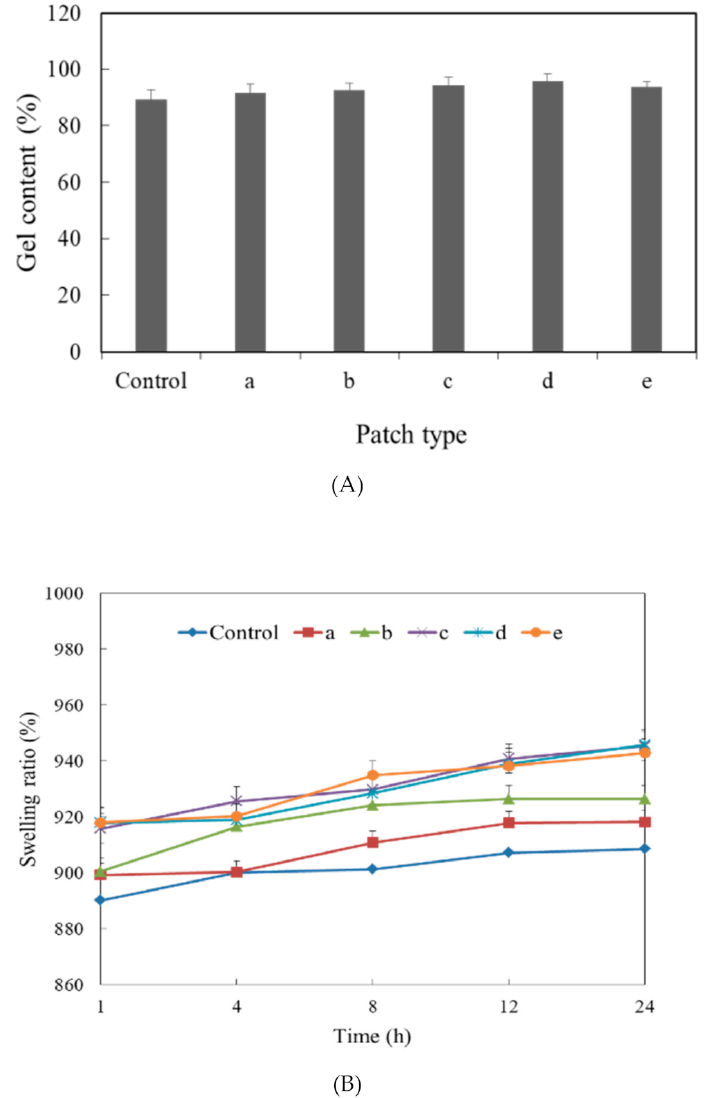
Figure 6. E ff ect of Centella asiatica extract (CAE) on the characteristics of hyaluronic acid-dextran (HA-Dex) hybrid hydrogel patches. E ff ect of CAE content on ( A ) the gel content and ( B ) the swelling ratio ( n = 3, mean ± SD). Control: HA-Dex hybrid hydrogel patches with no CAE; (a) 9.8:0.2, (b) 9.6:0.4, (c) 9.4:0.6, (d) 9.2:0.8, and (e) 9:1 wt% HA-Dex: